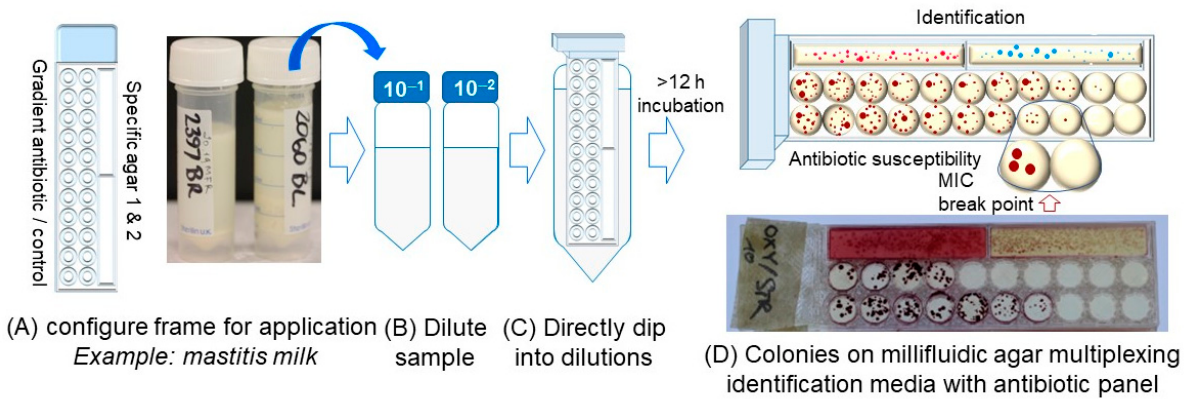
Figure 2. Dip-slide testing method. ( A ) Configure frame for application and mastitis milk samples. ( B ) Dilute sample into 2 fold, ( C ) Directly dip frame into dilutions, ( D ) Observe the results on frame.